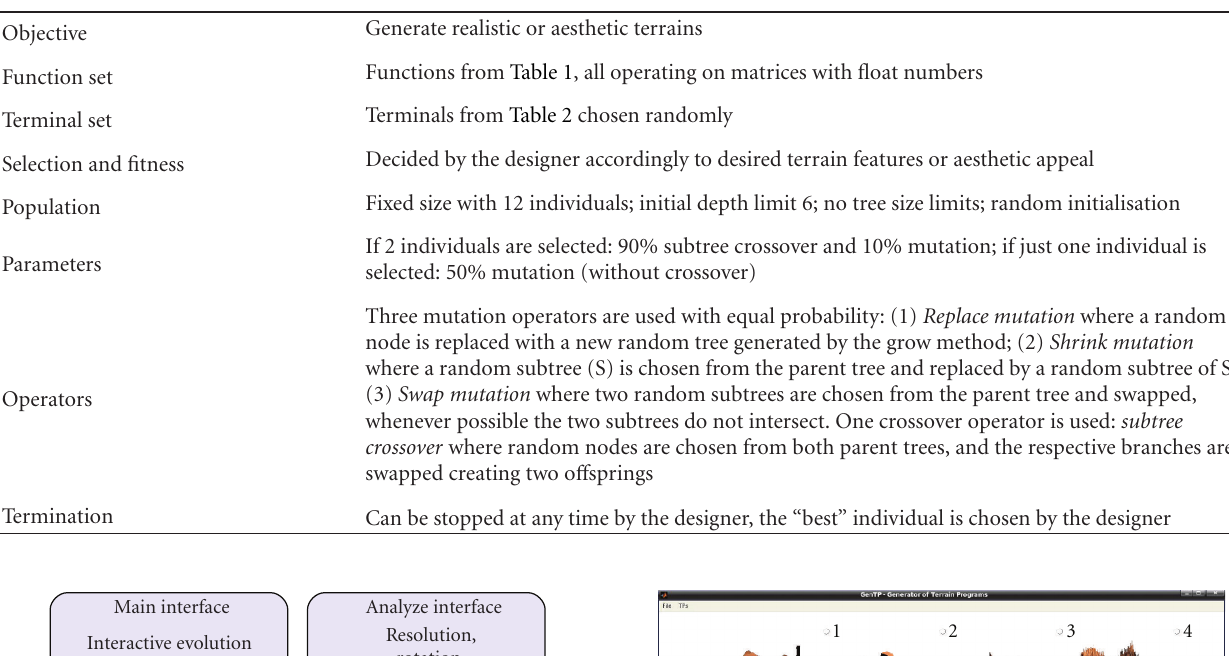
Table 3: Parameters for a GTP run.